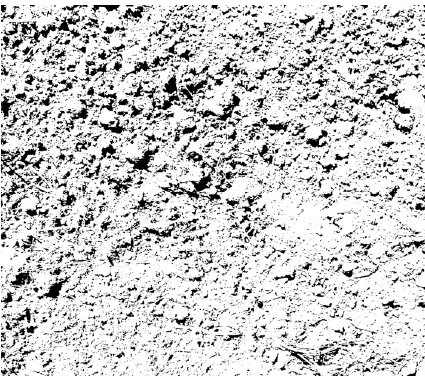
Fig. 5. Pin-meter used to measure soil height every